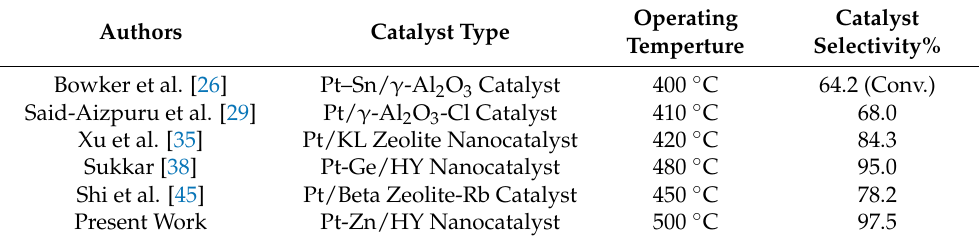
Table 5. The comparison of the present work results with the results of many authors over different kinds of catalysts (catalytic reforming of